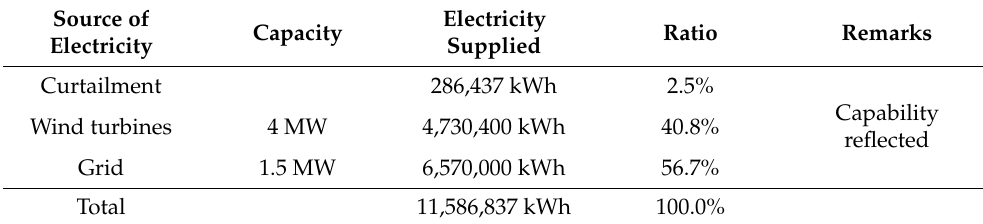
Table 42. The annual amount of electricity to be supplied to water electrolysis (Scenario VII).